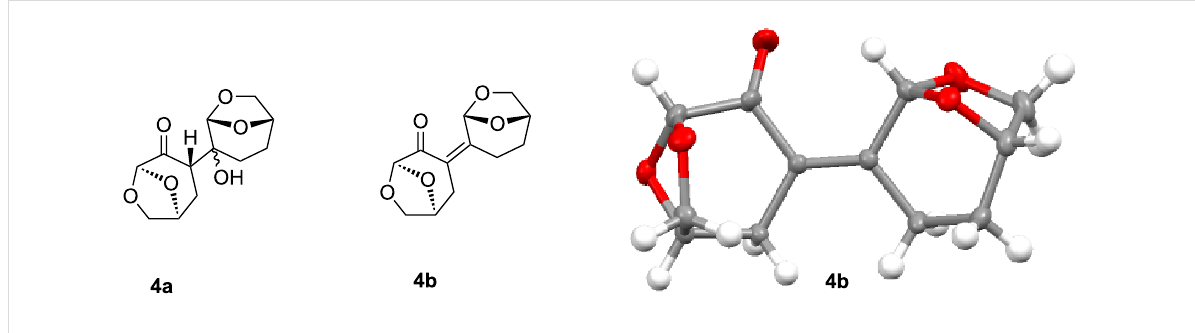
Figure 2: Aldol products 4a and 4b and single crystal X-ray structure of 4b .